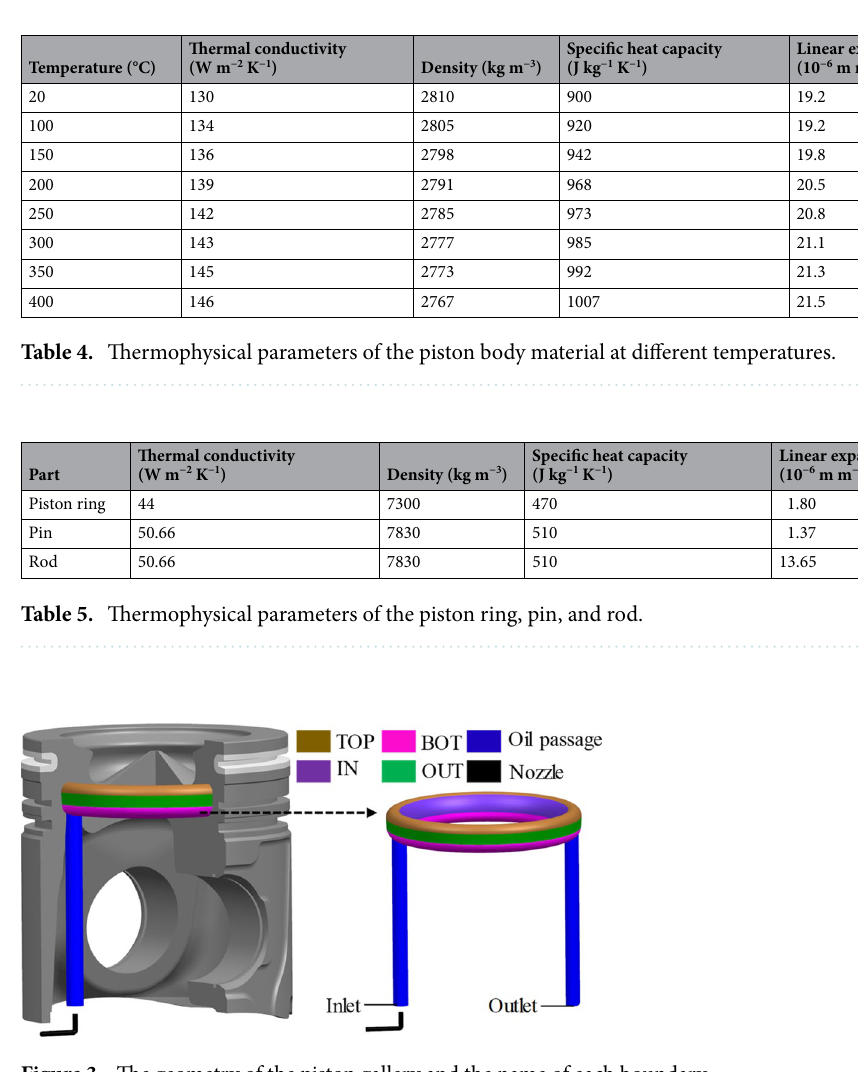
Figure 3. The geometry of the piston gallery and the name of each